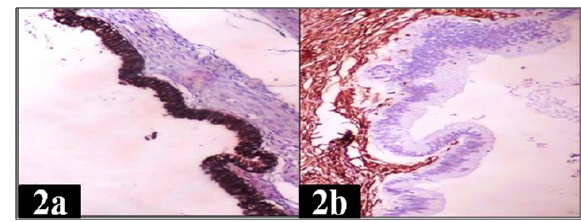
Fig 5. IHC expression of CK AE1/AE3 and vimentin in benign mucinous tumor of ovary (a) Strong membranous staining of CK (400X) (b) No immunostaining of vimentin (400X)